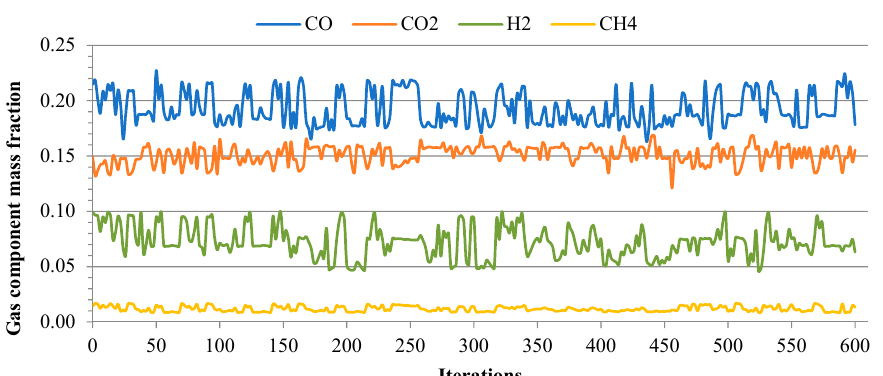
Figure 4 . Mass fraction variation with iteration in the simulation model.